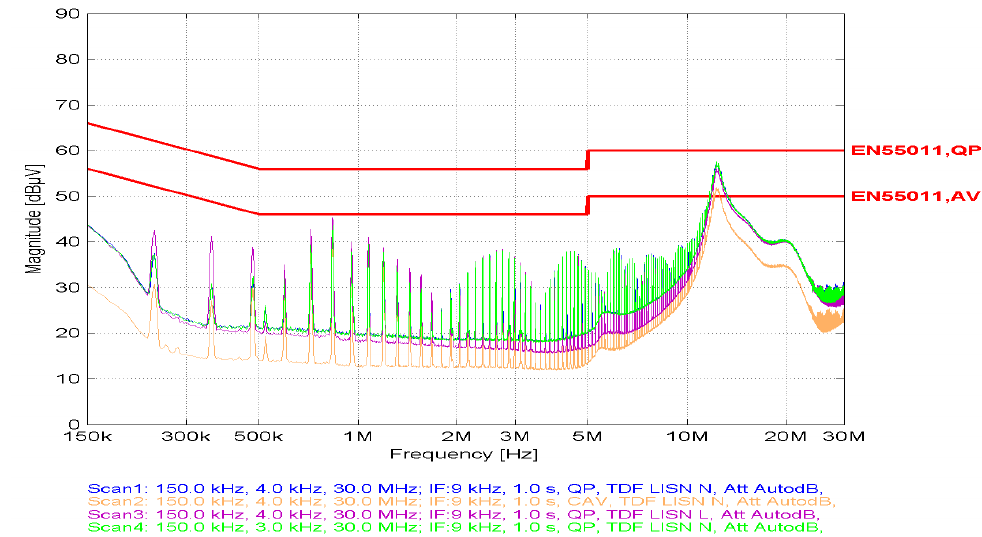
Figure 4. Attenuation level for ferrite No. 1 with the number of coils at 28 pcs.